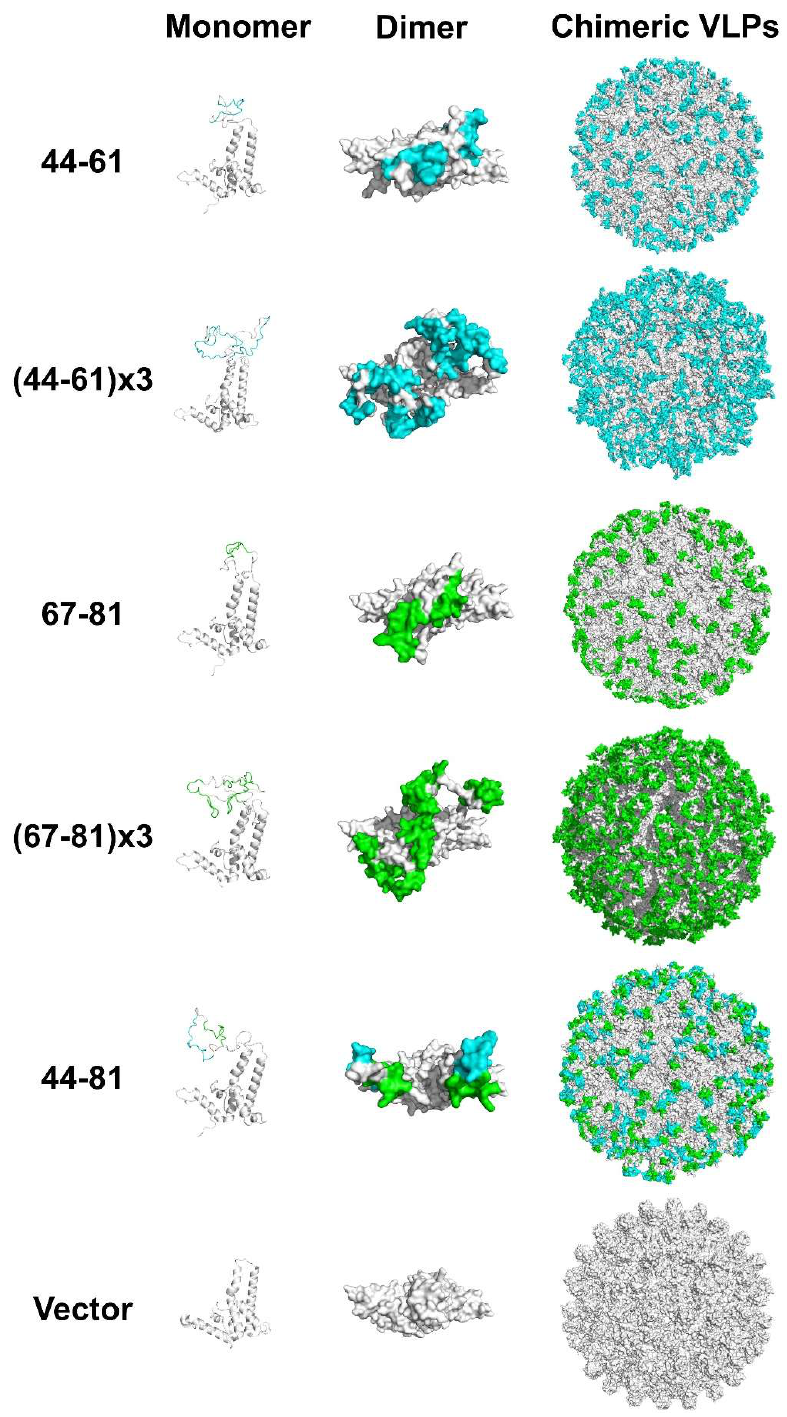
Figure 6. Structure models of chimeric VLPs. The monomer form of fusion proteins was drawn in cartoon patterns and listed in the left. The dimer form of fusion proteins was edited in surface patterns and placed in the middle. Chimeric VLPs were rendered in surface patterns and set in the right. The fusion proteins were the homology modeling result using SWISS-MODEL (the template PDB ID: 3J2V).